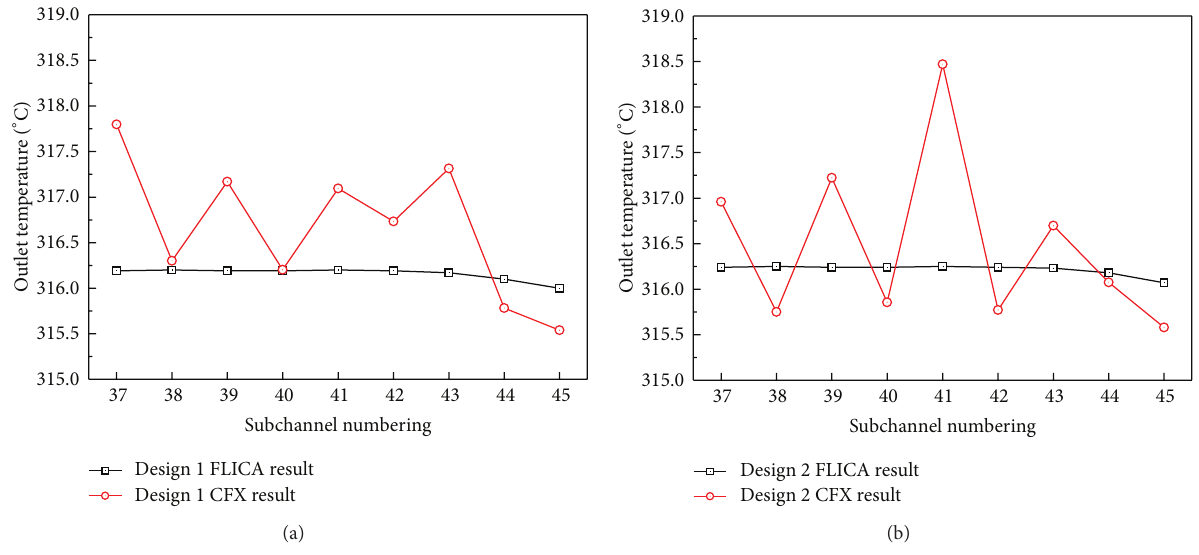
Figure 12: Side subchannel outlet temperature in CFX & FLICA (mixing coefficient equal to 0.063)